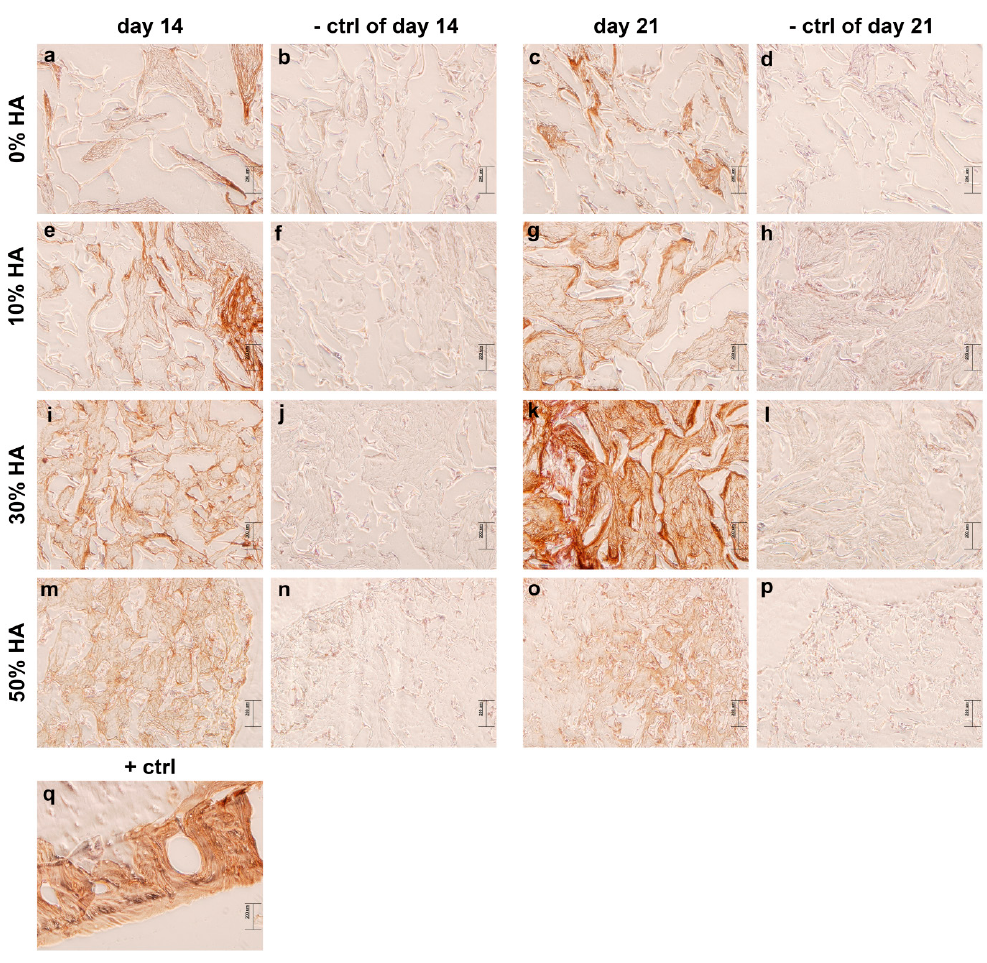
Figure 5. Immunohistochemical examination of collagen I on different scaffolds after 14 and 21 days of osteogenic induction. Brown color indicates positive staining. Weak staining is observed in samples with 0% HA ( a , c ). Very strong staining was observed in scaffold composed of 30% HA after 21 days of osteoinduction ( k ). Moderate staining for collagen I was shown for scaffolds composed of 10 and 50% HA ( e , g , m , o ), as well as for scaffold composed of 30% HA after 14 days of osteoinduction ( i ). As negative controls ( − ctrl of day 14 and − ctrl of day 21), sections were processed for each sample in the absence of the suitable primary antibody ( b , d , f , h , j , l , n , p ). Human bone was used as a sample for positive control (+ctrl) ( q ). Representative images are shown at 100 × magnification ( n = 3). Scale bar represents 200 µm.